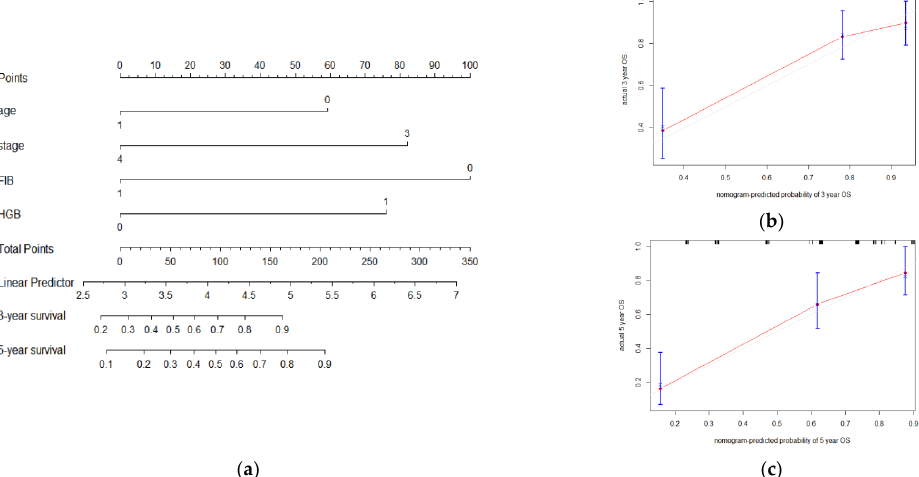
Figure 7. Nomogram analysis ( a ) and calibration ( b , c ) of the blood – clinical model for OS prediction in LSCC.